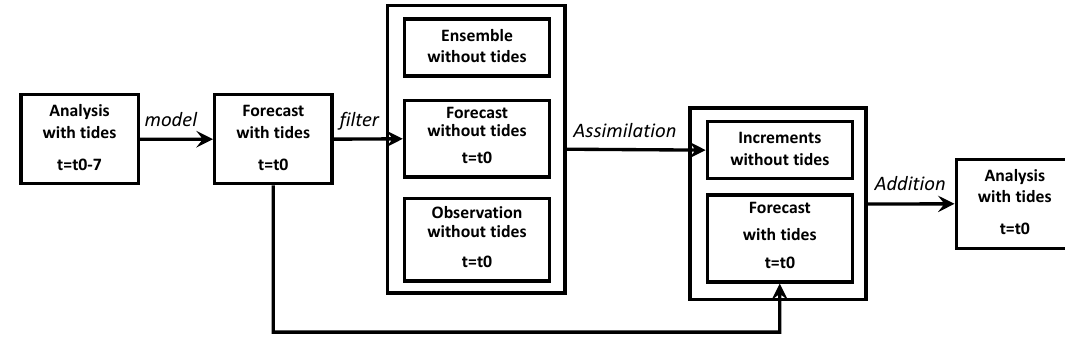
Fig. 7. Schematic of the strategy used to assimilate SLA data, to correct the mesoscale circulation while leaving the tidal signal unchanged.